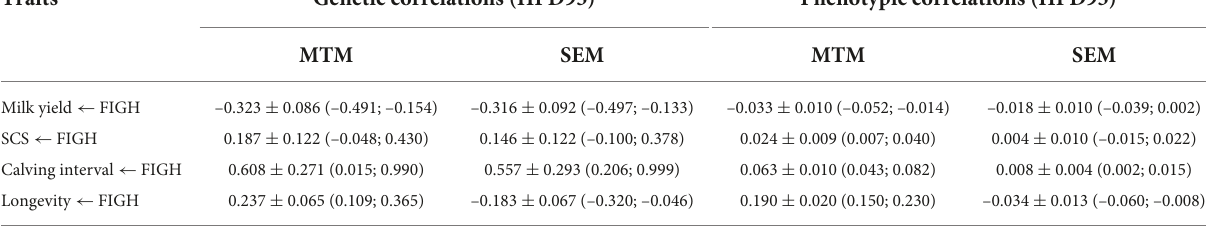
TABLE 4 Posterior means ± posterior standard deviations, and 95% high posterior density regions (HPD95) for genetic and phenotypic correlations between fighting ability and the other traits under multiple trait model and structural equation